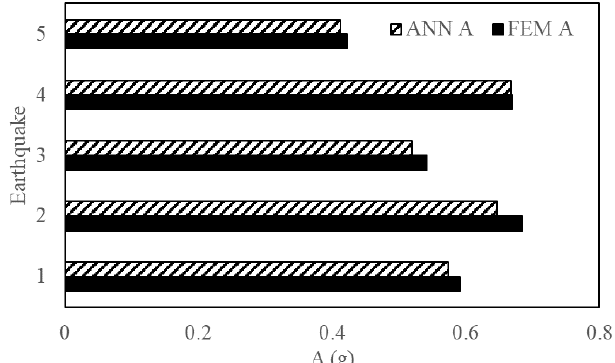
Figure 13. Base shear of a four-story structure obtained from ANN and NLTHA for five EQs.